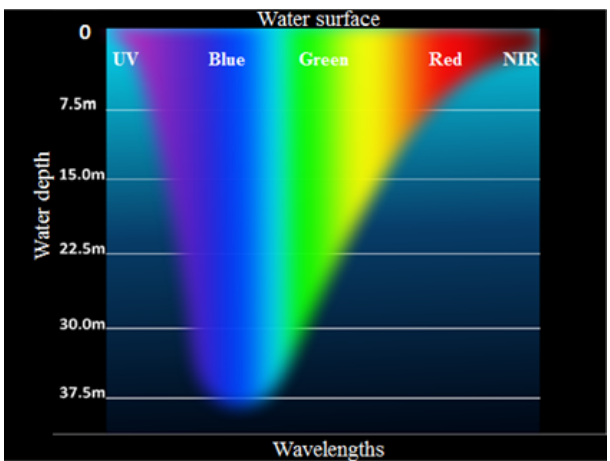
Figure 1. Vertical penetration of electromagnetic spectrum in shallow water (adapted from Morris, 2019, https://commons. wikimedia.org/wiki/Category:Visible_spectrum_illustrations, last access: 5 November